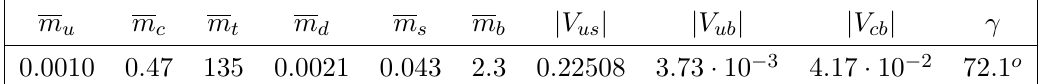
Figure 13 . Distribution of the lower-mass bounds (in TeV) for a million pairs of randomly gener- ated anarchic Yukawa matrices, Y U;D , such that the SM quark masses and CKM matrix elements are at their experimental values. The lower bounds on the M u;d;Q masses follow from low-energy observables assuming that only one type of gear is active at a time.